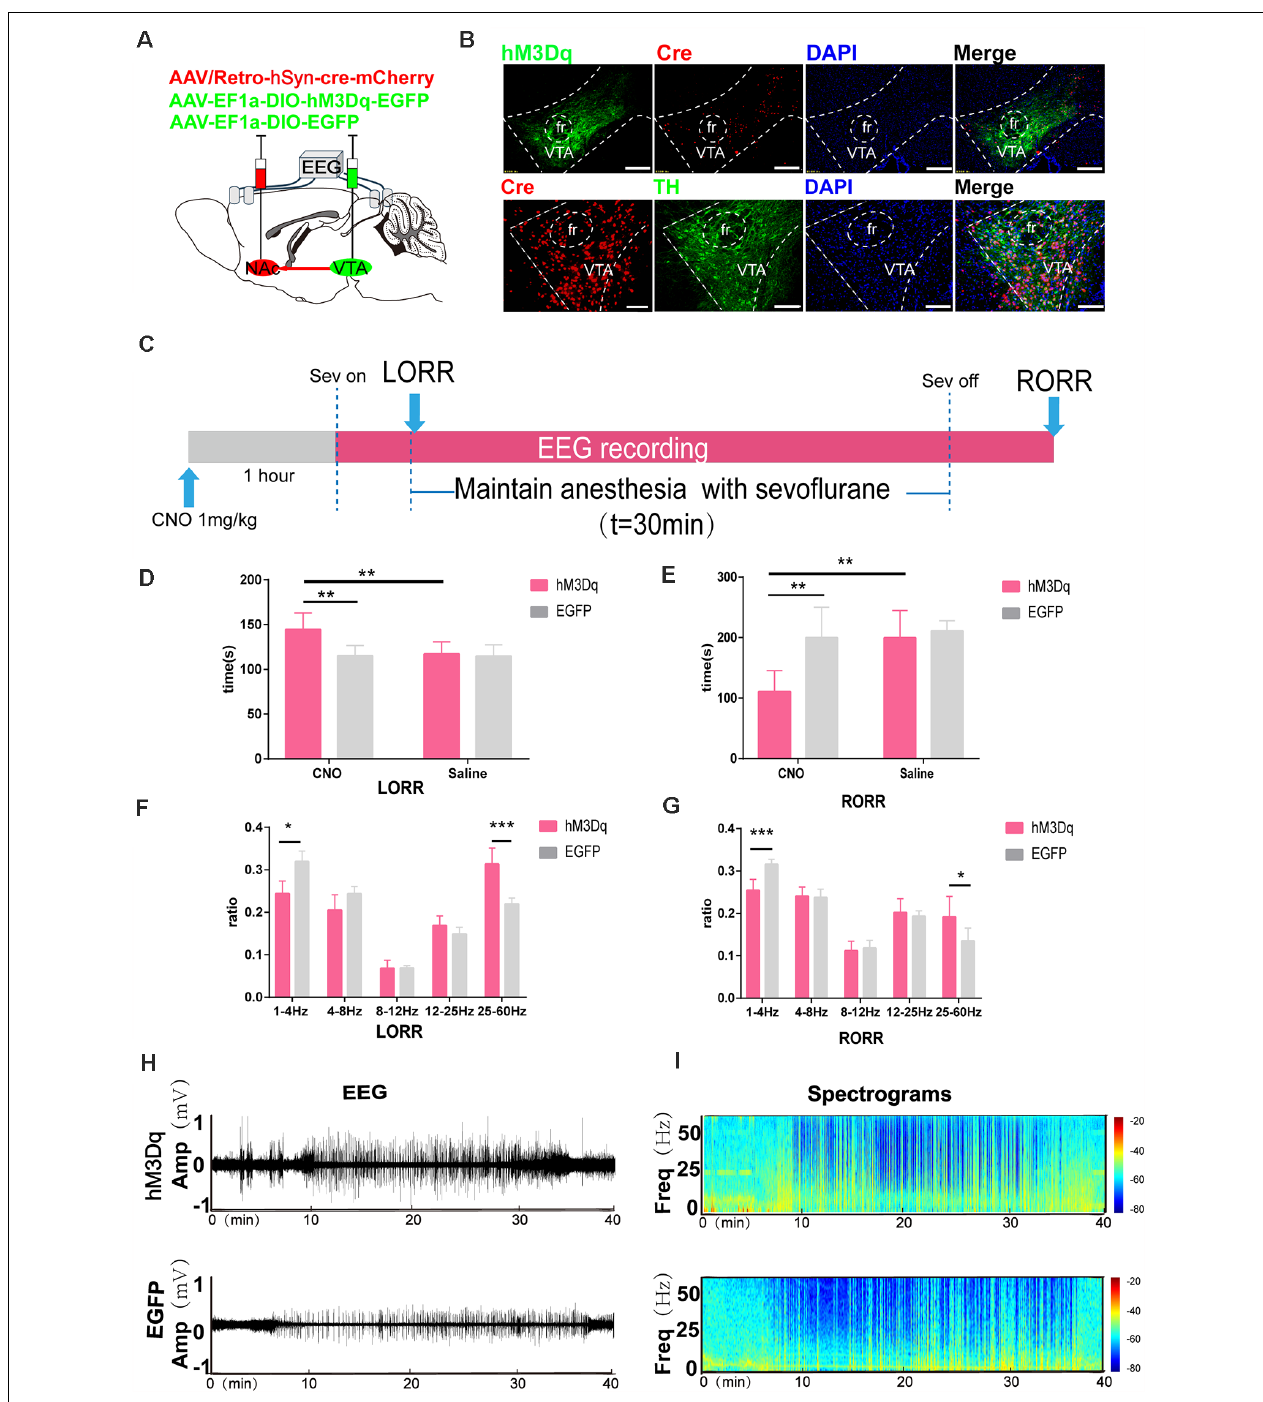
FIGURE 5 | Chemogenetic activation of VTA-NAc pathway neurons facilitate emergence from sevoflurane anesthesia. (A) Schematic of the experimental protocol. Cre-dependent hM3Dq was injected into the VTA of mice, while retrograde cre was injected into the NAc. (B) Expression of hM3Dq-EGFP (green) and retrograde cre-mCherry (red) in the VTA and NAc showing dopaminergic projections from the VTA to the NAc in the mouse brain (above). Scale bars: 200 µ m. Immunofluorescence of cre-mCherry (red) and TH (green) in the VTA (below) Scale bars: 100 µ m. (C) Experimental timeline of the behavioral test and EEG recording. (D) CNO-mediated hM3Dq activation notably prolonged the LORR time. (E) CNO-mediated activation significantly shortened the RORR time. (F) CNO-mediated hM3Dq activation decreased δ bands and enhanced γ bands during the LORR process. (G) CNO-mediated hM3Dq activation decreased δ bands and enhanced γ bands during the RORR process. (H,I) Representative EEG traces and heat map from the two groups. CNO: clozapine N-oxide. Data are presented as the mean ± SD. * p < 0.05, ** p < 0.01, and *** p < 0.001, n = 8, by paired and unpaired paired t -test.